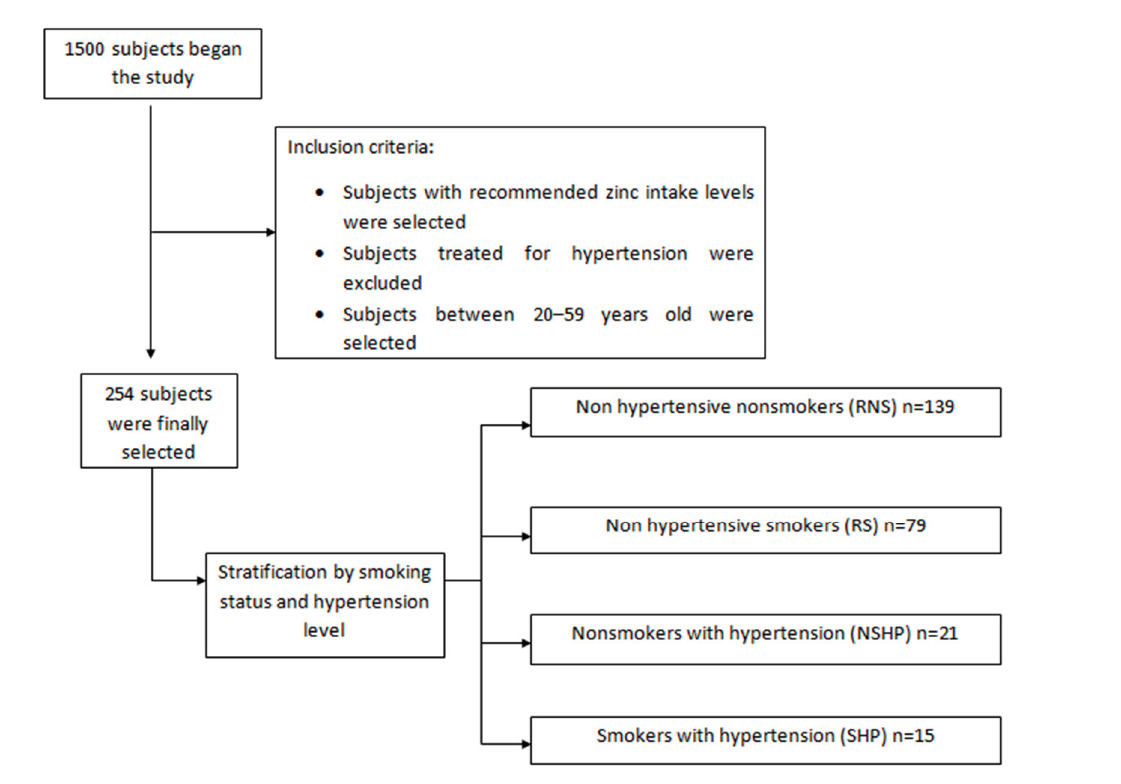
Figure 1. Flowchart of the study